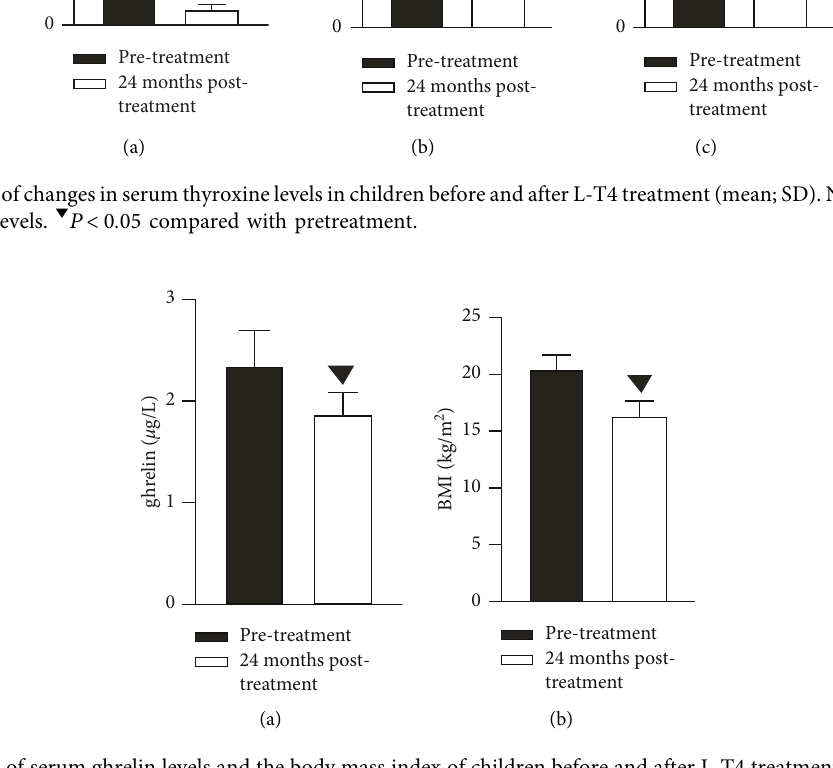
Figure 3: Comparison of serum ghrelin levels and the body mass index of children before and after L-T4 treatment (mean; SD). Note: (a) ghrelin levels and (b) BMI levels; compared with pretreatment, ▼ P < 0 . 05.